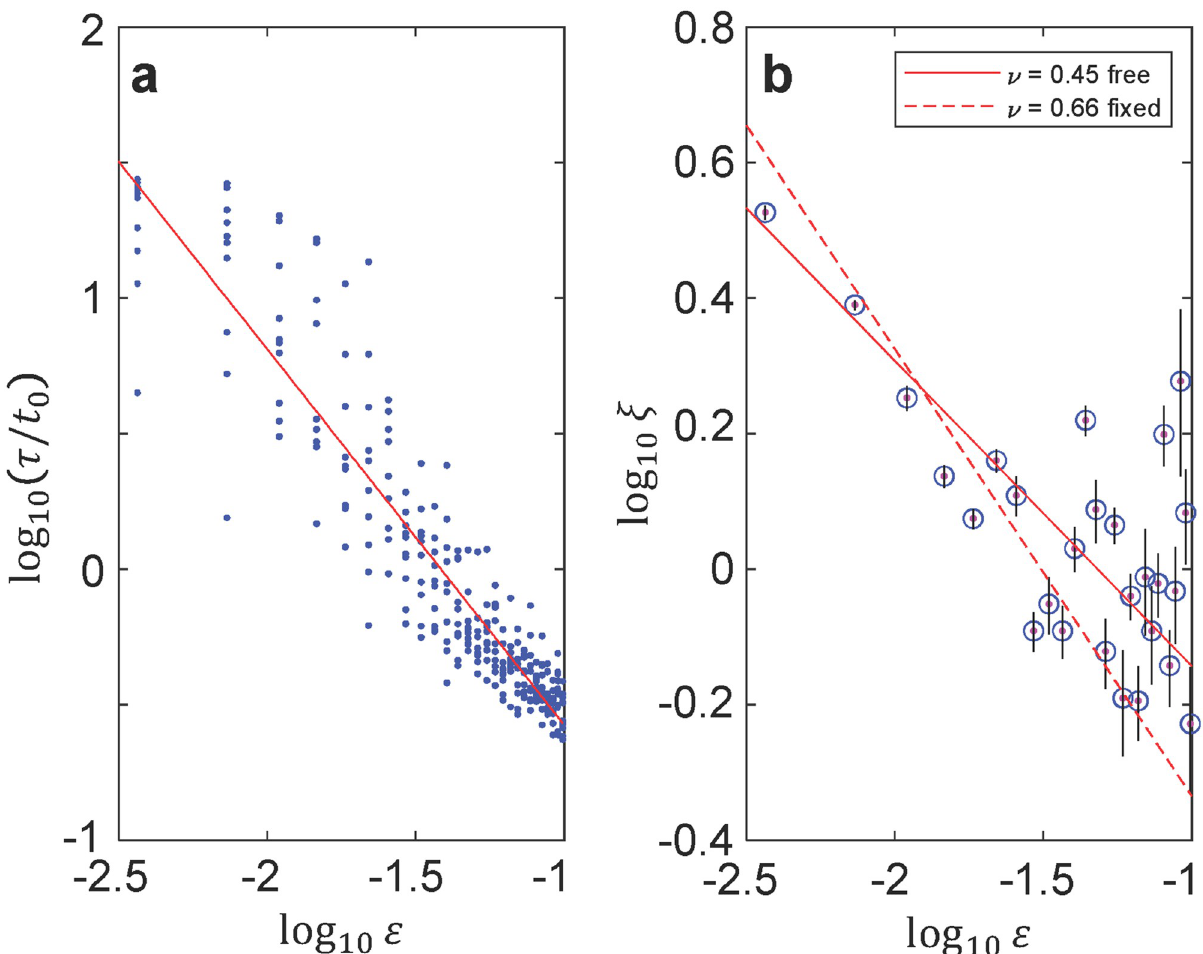
Fig 4. Fitting critical behavior. (a) τ vs. ε extracted from ten simulation runs with the same parameters on a log-log scale. Power law fit is shown in red, yielding zν = 1.39 ± 0.03 and τ 0 = (1.1 ± 0.1) × 10 − 2 t 0 . (b) Same as (a) but showing ξ vs. ε from 15 runs. At each ε , C 7 ( r ) was extracted from each run and averaged together before fitting to find ξ . Power law fits are shown in red, yielding ν = 0.45 ± 0.04 and ξ 0 = 0.25 ± 0.05, with ν varied in the fit (solid line) or ξ 0 = 0.101 ± 0.005 with fixed ν = 0.66 (dashed